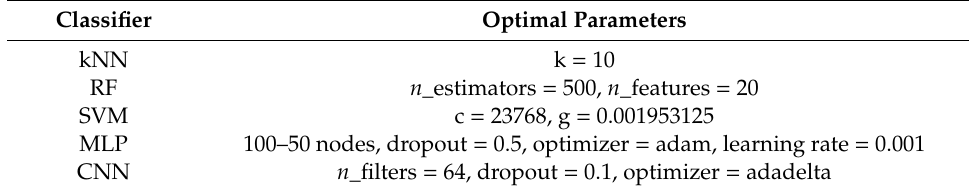
Table 1. Hyperparameters of different machine learning and deep learning classifiers used in this study. KNN: k-nearest neighbors; RF: random forest; SVM: support vector machine; MLP: multi-layer perceptron; and CNN: convolutional neural network.